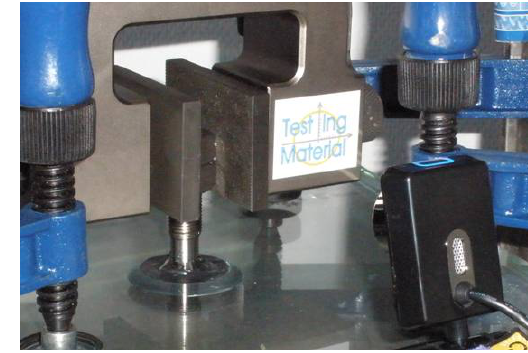
Figure 10: Point support type P1. Figure 11: Test set-up for point support P1.